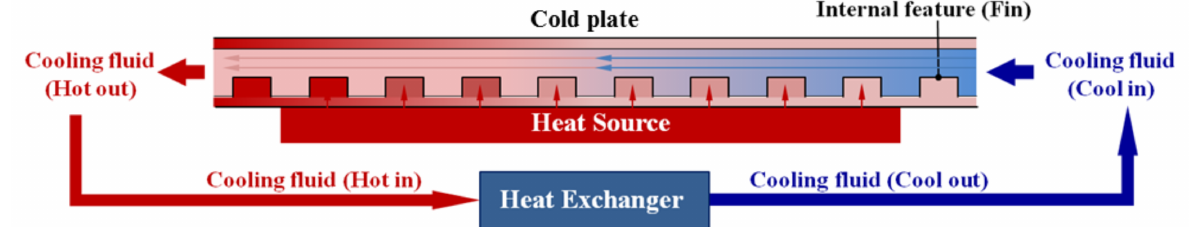
Figure 2. Schematic diagram of the operation principle of fluid circulation-type cold